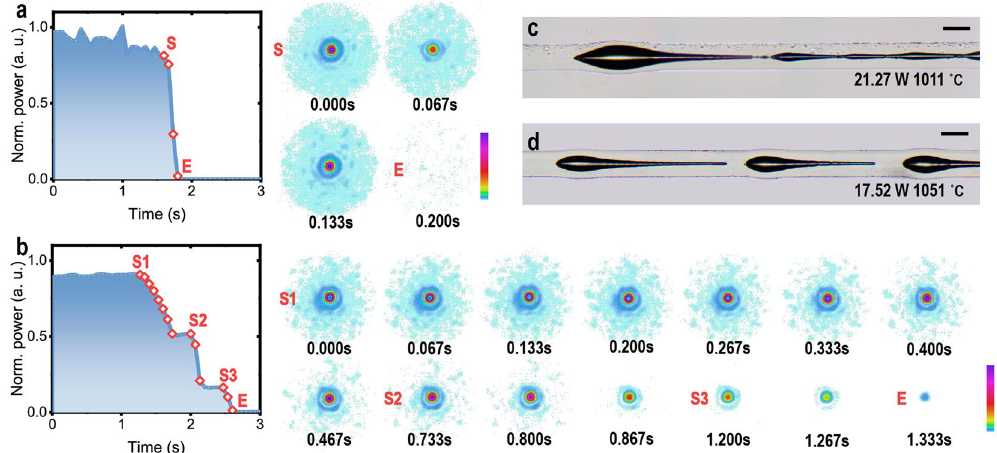
Figure 6. Evolution of beam profiles after the IFF. ( a ) Evolution of beam profile after IFF-with-PFF. ( b ) Evolution of beam profile after IFF-without-PFF. Shown in the left are normalized real-time powers of beam spots varying with time; 1.0 a.u. (vertical) equal the powers measured at the beginning of the tests. The red diamonds labeled on the curves correspond to the beam profiles shown right-sided in sequence. ( c ) and ( d ) Micrographs showing the cavities generated after the IFF in the cases of ( a ) and ( b ), respectively. They are made by stitching consecutively captured pictures together. At the bottom-right of the micrographs are the input powers of the fibres and the temperatures at which the IFF happened; the bars are of 130 μ m